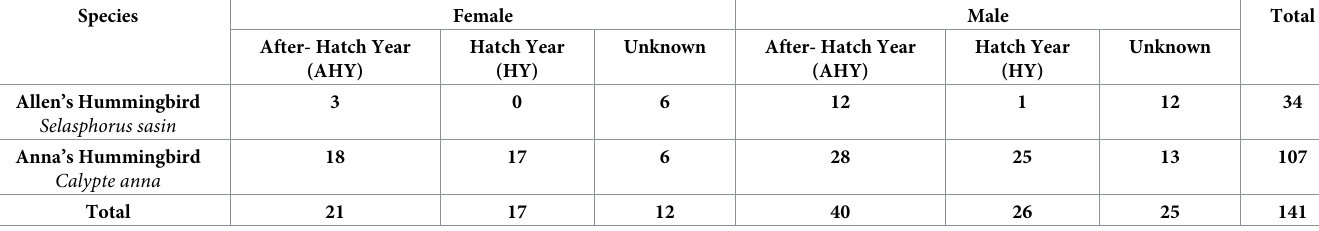
Table 3. Demographic composition of tagged hummingbirds visiting feeding stations at Sites 1 and 2 in Northern California and Site 3 in Southern California from September 2016 to March 2018. Allen’s Hummingbirds were tagged only at Site 3 in Southern California. Species Female After- Hatch Year